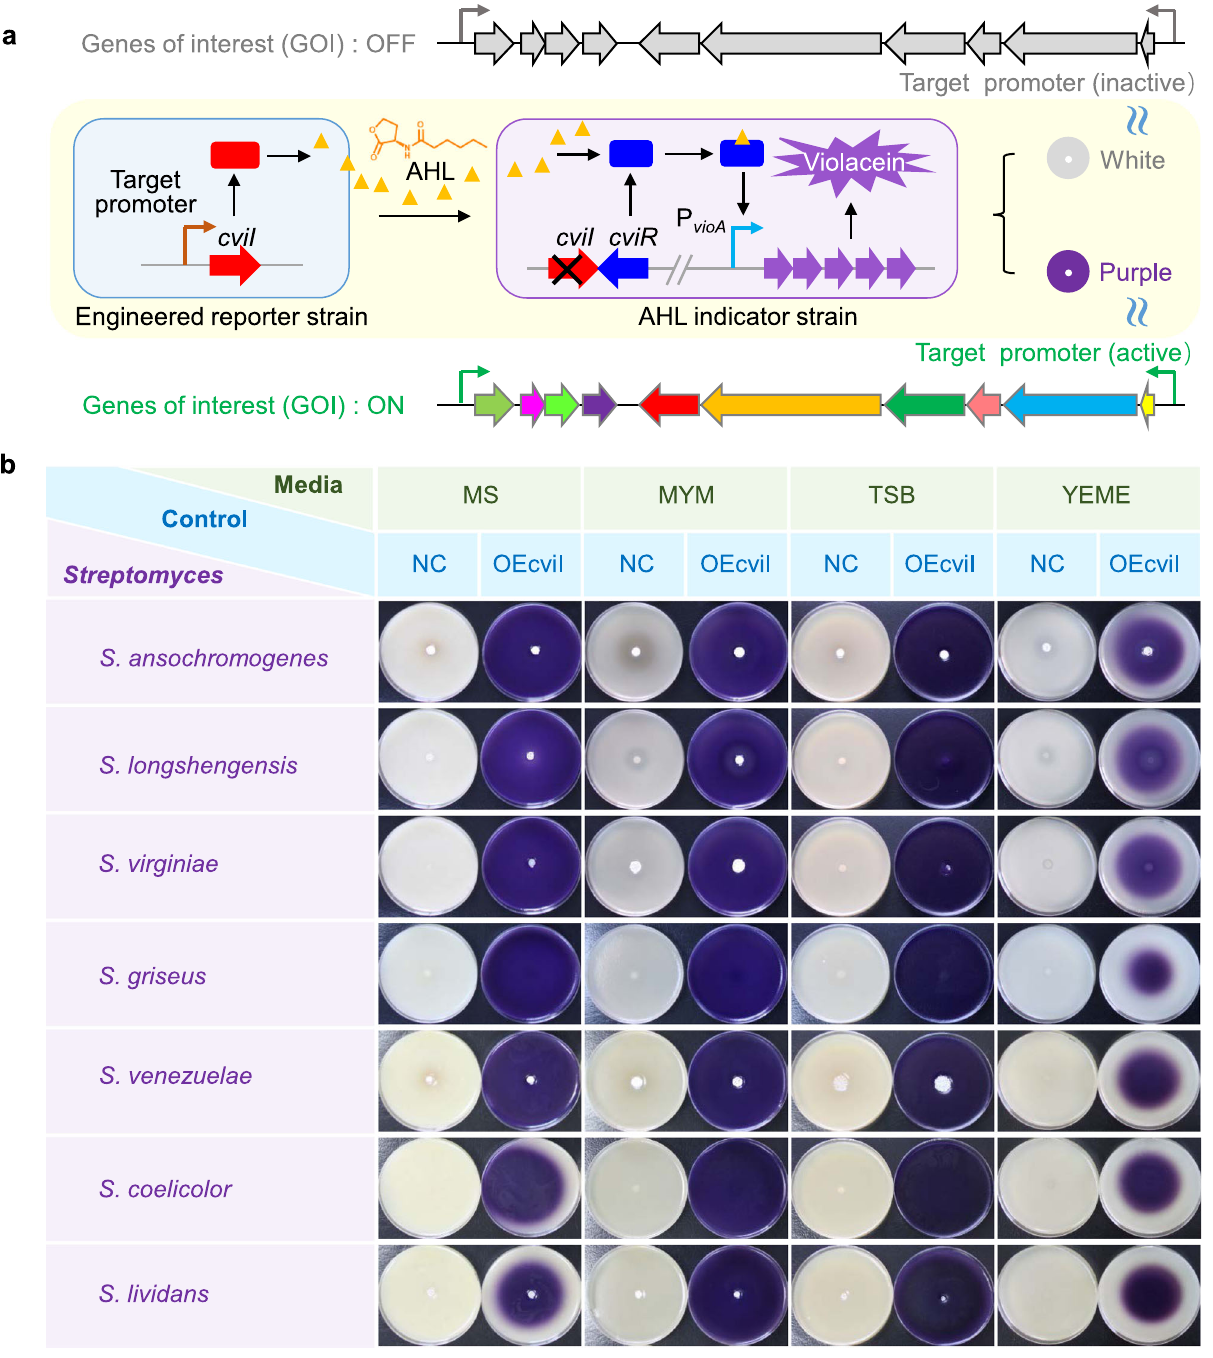
Fig. 1 Schematic illustration and feasibility veri fi cation of VRS-bAHL in Streptomyces . a Schematic illustration of VRS-bAHL. VRS-bAHL was constructed based on AHL QS of C. violaceum CV31532. Speci fi cally, cviI (the AHL synthase gene of CV31532) was used as the reporter gene in Streptomyces and CV026 (the cviI de fi cient mutant of CV31532) as AHL indicator strain. cviI was fused with target promoters and then introduced into Streptomyces . The resulting AHL signaling molecules, such as C6-HSL, can be recognized by receptor CviR in indicator strain CV026 to form a complex, whose binding to P vioA , the promoter of violacein biosynthetic genes, would activate violacein production. Purple pigment (violacein) can be directly observed or measured for quanti fi cation using suitable instruments, which indicates the expression level of genes of interest (GOI). b Feasibility veri fi cation of VRS-bAHL in Streptomyces . OEcviI (positive control strain harboring pSPhrdB-cviI for overexpression of cviI driven by P hrdB on pSET152) and NC (negative control strain harboring the blank plasmid pSET152) strains were inoculated at the center of agar media plates. After incubation for three days, double-layer plate method was applied to detect AHL via violacein formation in indicator strain CV026. Seven Streptomyces strains ( S. ansochromogenes 7100, S. longshengensis CGMCC 4.1101, S. virginiae CGMCC 4.1530, S. griseus IFO 13350, S. venezuelae ATCC 10712, S. coelicolor A3(2) and S. lividans TK23) were chosen for the feasibility veri fi cation of VRS-bAHL on four types of media (MS, MYM, TSB and YEME), and two independent experiments displayed similar results.